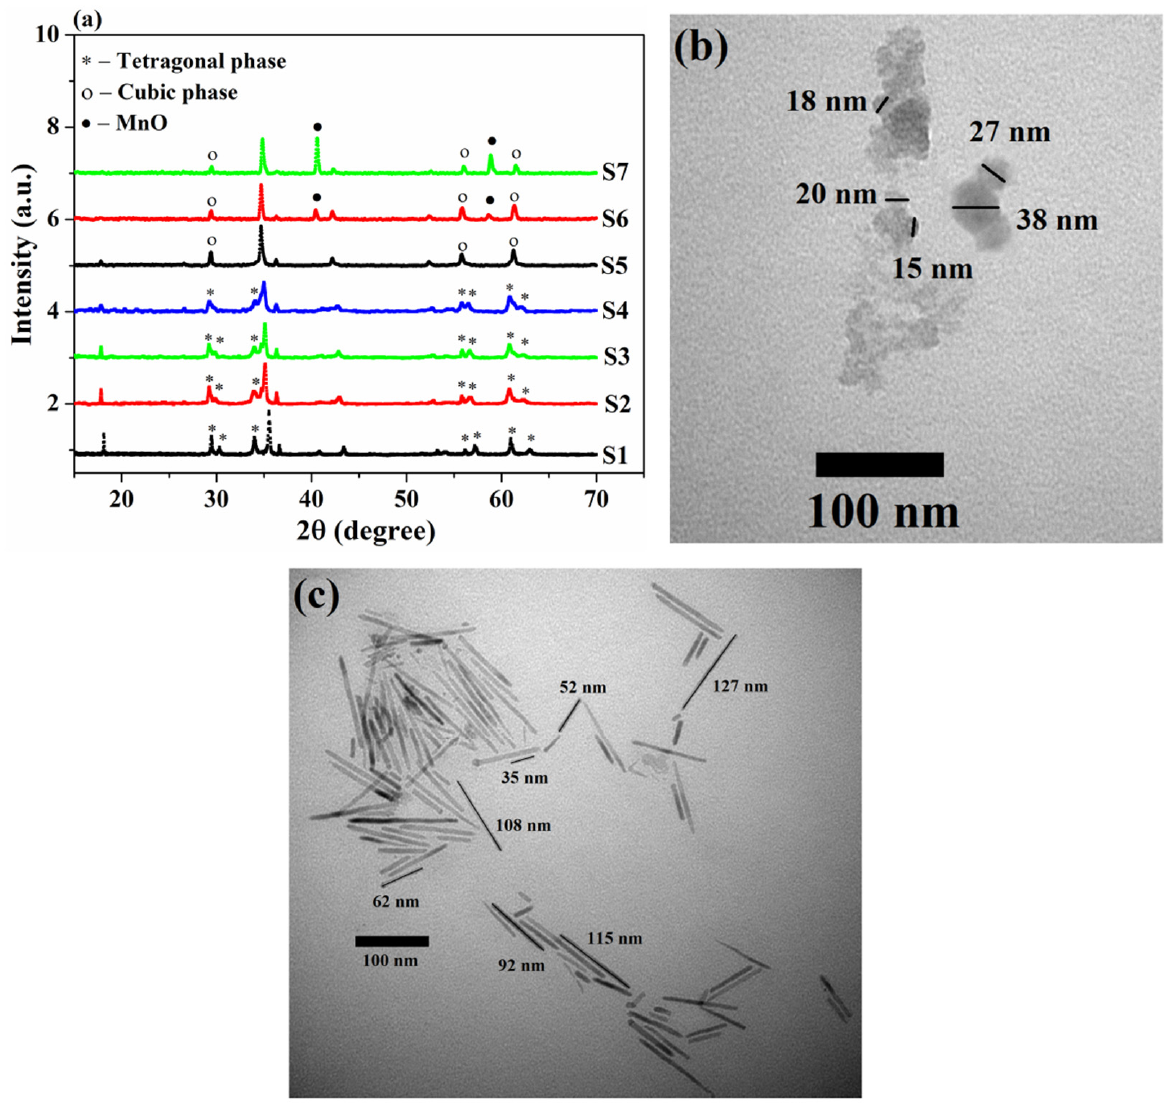
Figure 3. ( a ) XRD patterns of the as-synthesized sample and samples after heating to various temperatures; ( b , c ) TEM images of the samples heated during high-temperature magnetic measurements to 600 °C and 700 °C, respectively.